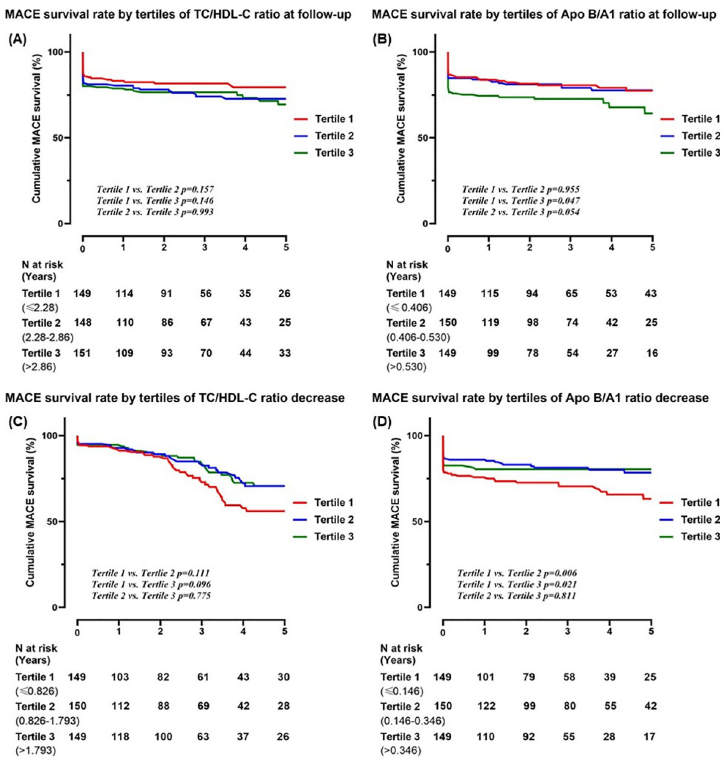
Fig 2. Kaplan-Meier curves of MACE survival rate by tertile of TC/HDL-C ratio at follow-up (A). Kaplan-Meier curves of MACE survival rate by tertile of Apo B/A1 ratio at follow-up (B). Kaplan-Meier curves of MACE survival rate by tertile of TC/HDL-C ratio decrease (C). Kaplan-Meier curves of MACE survival rate by tertile of Apo B/A1 ratio decrease (D). Apo A1; apolipoprotein A1, Apo B; apolipoprotein B, HDL-C; high-density lipoprotein cholesterol, MACE; major cardiovascular adverse event, TC; total cholesterol.